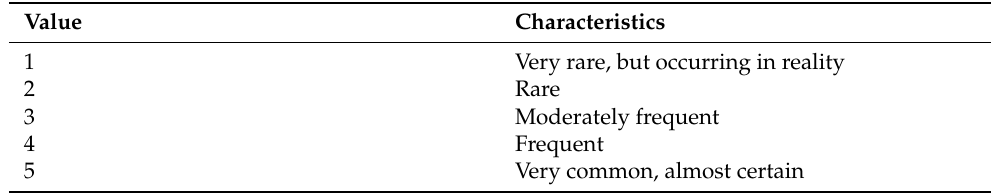
Table 2. Determination of accident probability (P) (frequency) for hazards and exposure to risk of C. difficile and HAI infections.